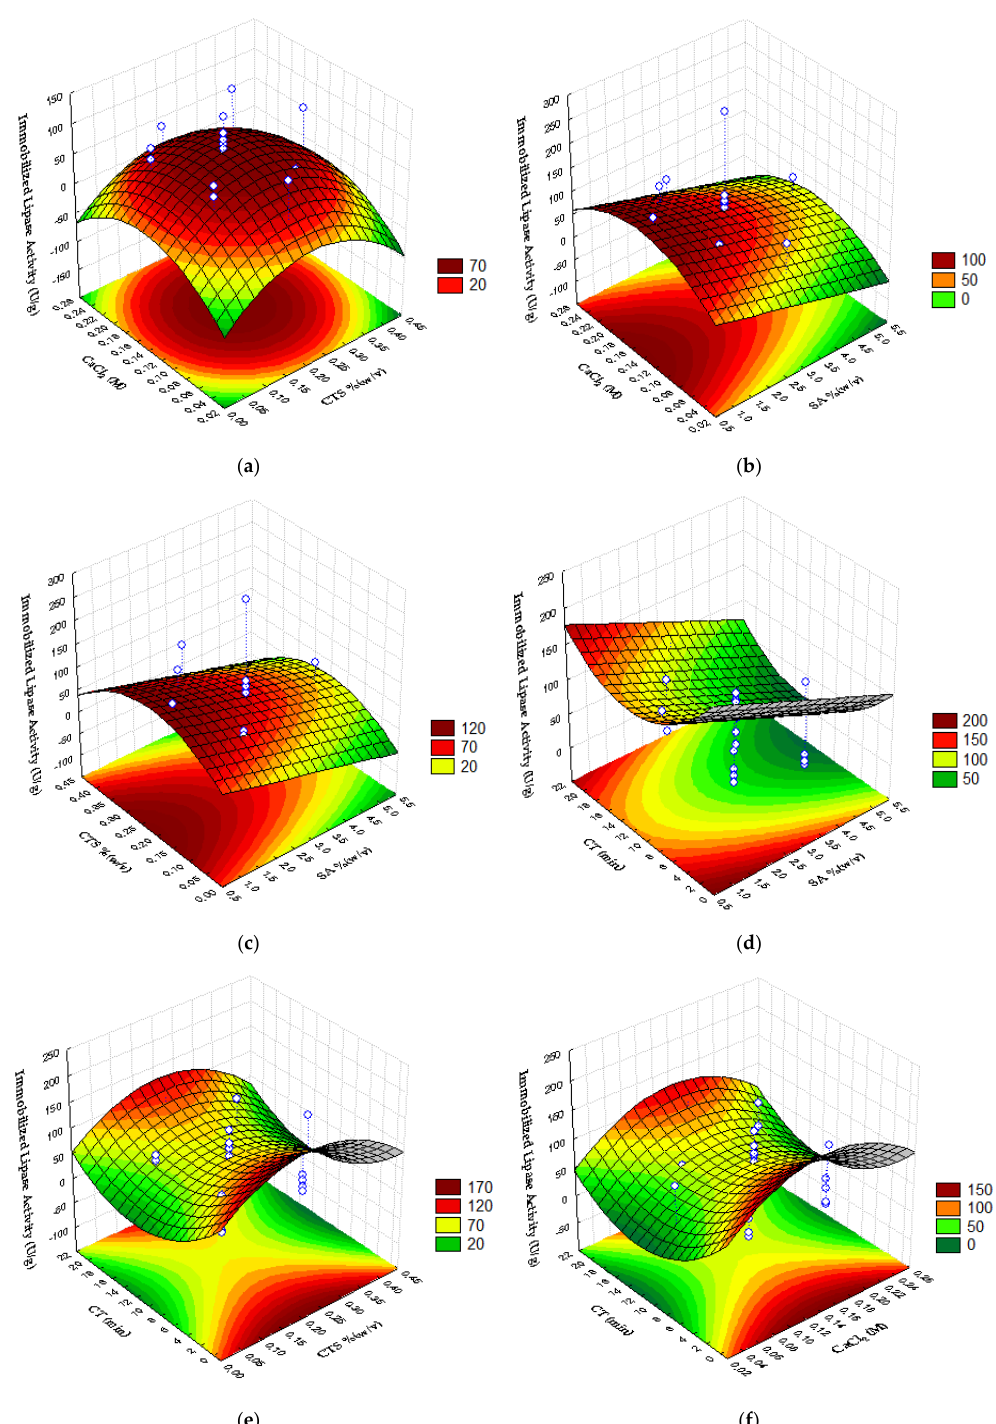
Figure 3. Response surface for the Immobilized Lipase Activity as a function of sodium alginate concentration, chitosan concentration, calcium chloride concentration, and time of complexation; ( a ) CaCl 2 × CTS; ( b ) CaCl 2 × SA; ( c ) CTS × SA; ( d ) CT × SA; ( e ) CT × CTS; ( f ) CT × CaCl 2